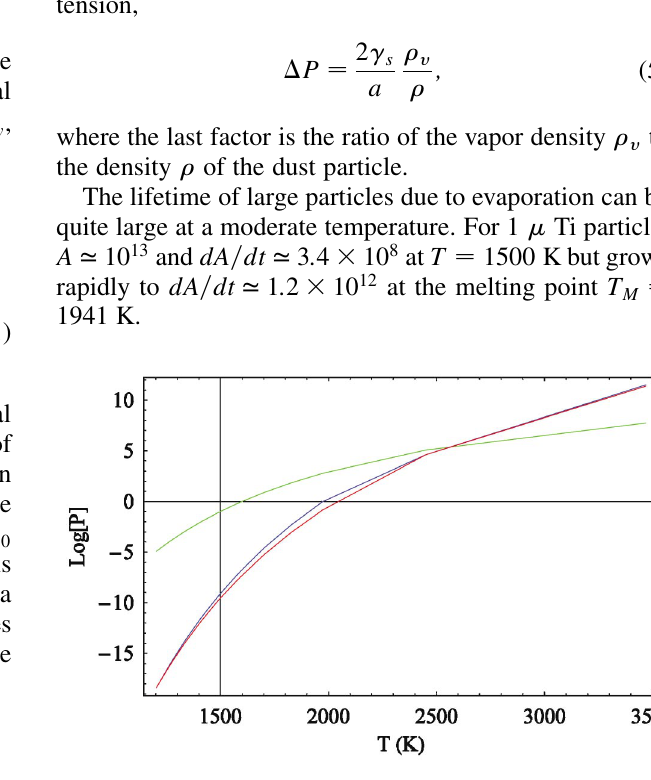
FIG. 1. (Color) The pressure P (cid:6) T (cid:7) in Pascal for Ti. Interpolating function, see Eq. (4), is shown by the blue and the experimental data by the black lines. The red line is pressure parametrization according to Ref.